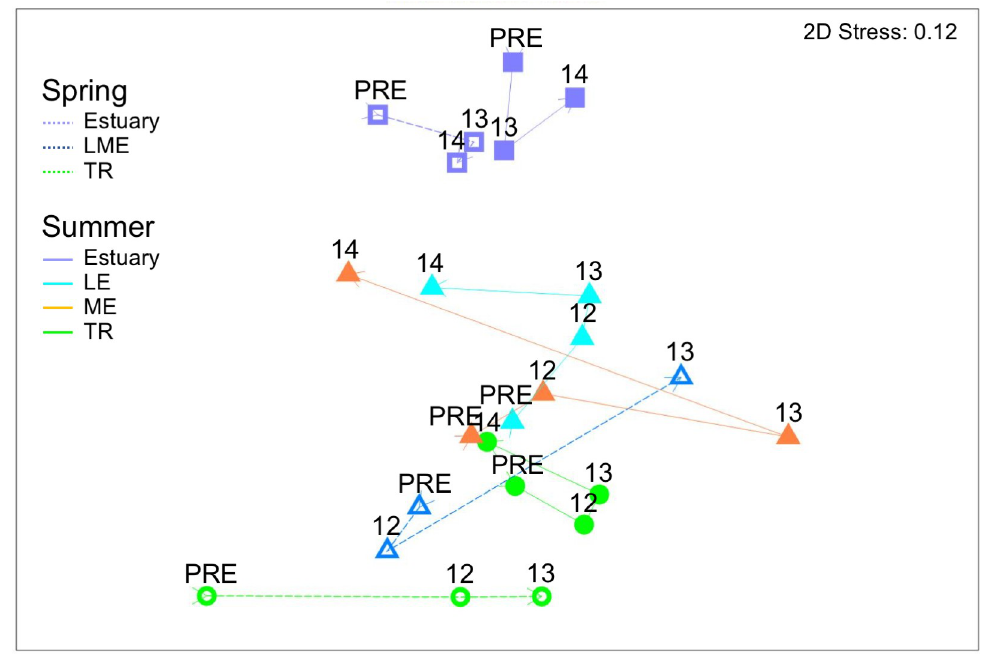
Fig 9. Fish diet nMDS plots of data centroids. Trajectories show direction of change by season, year and section for energetic composition. All data are fourth-root transformed.